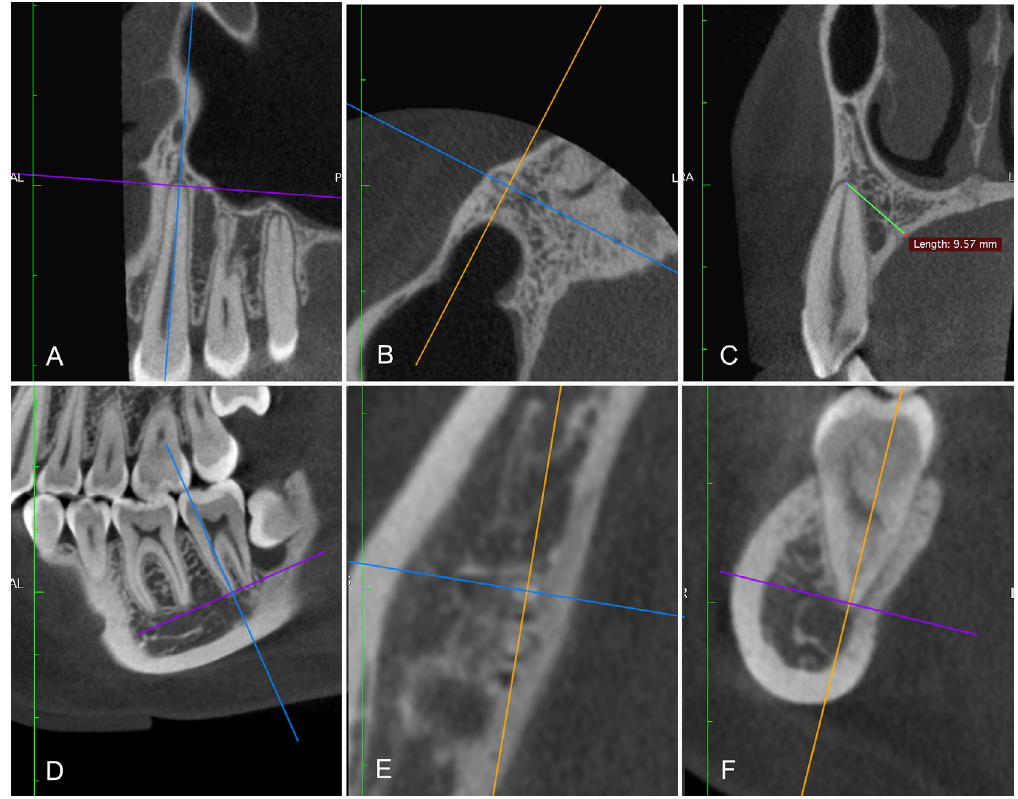
Figure 1- CBCT images in the sagittal, axial, and coronal planes (A-F). Standard reference for the location of the apical foramen was the main root canal. Axial navigation was used for each root